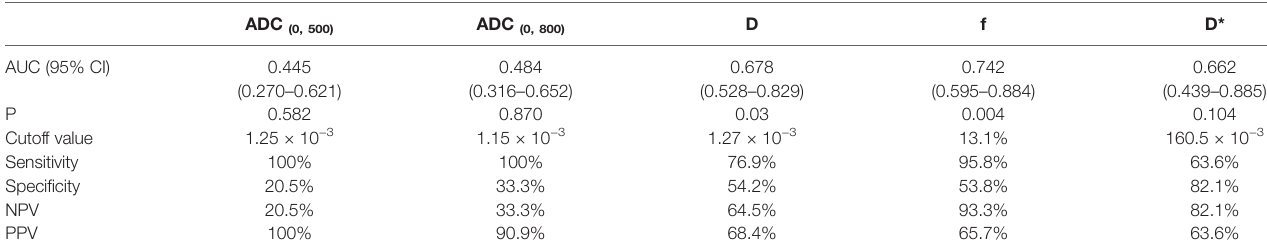
TABLE 3 | ROC curve of ADC (0, 500) , ADC (0, 800) , D, D*, and f